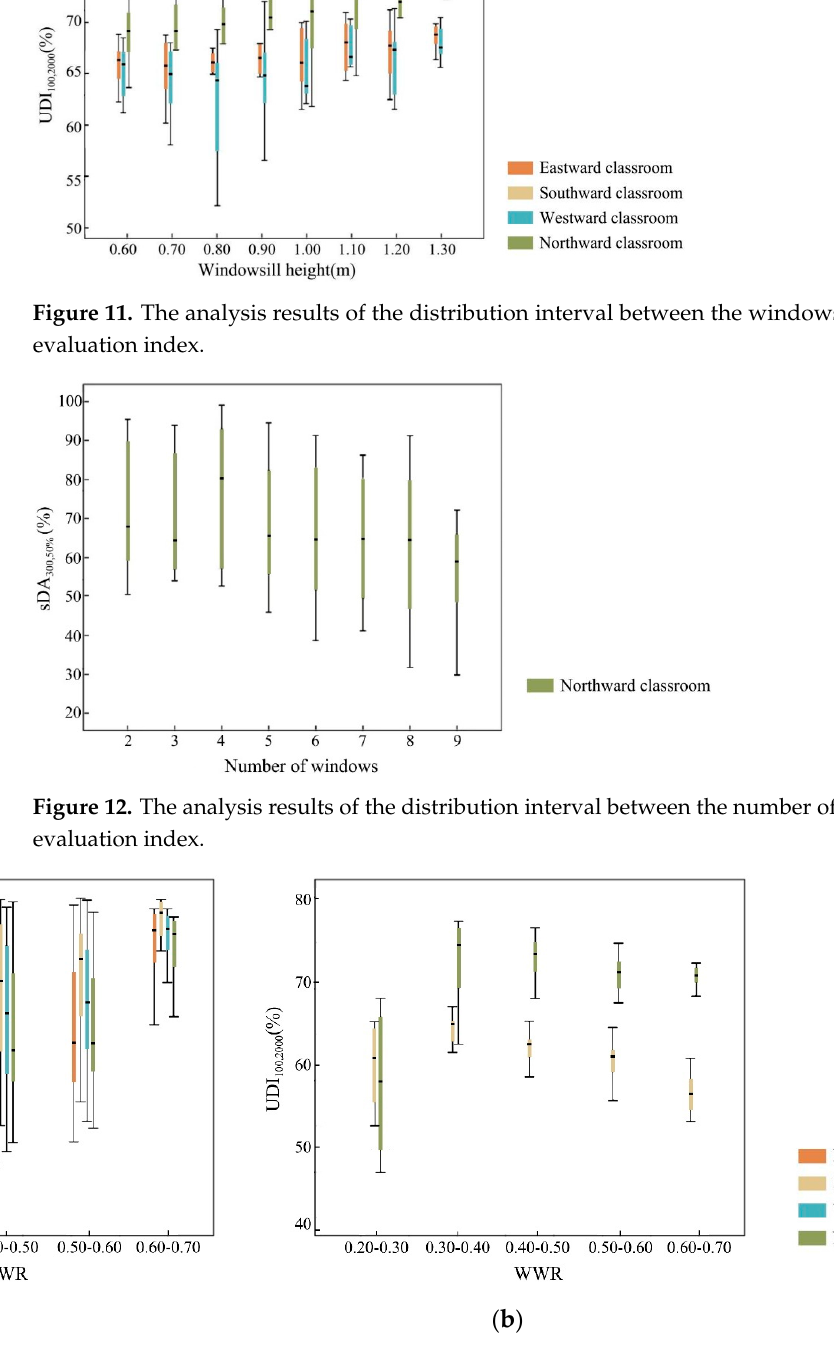
Figure 13. The analysis results of the distribution interval between WWR and the evaluation indices: ( a ) the analysis results of sDA 300,50% ; ( b ) the analysis results of UDI 100-2000 .